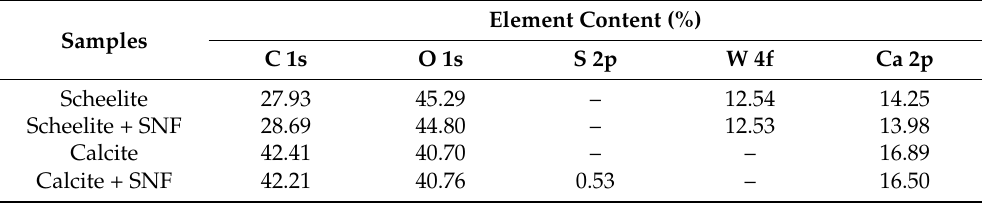
Table 4. Relative contents of the main elements on the scheelite and calcite surfaces in the presence and absence of